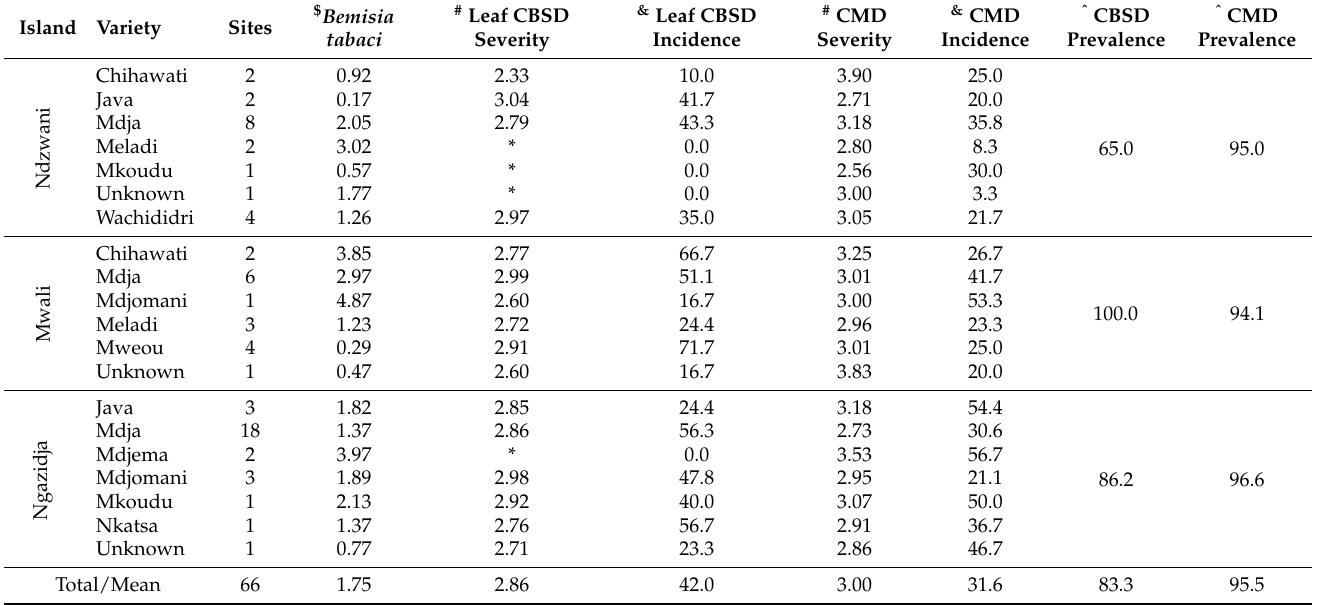
Table 1. Incidence, prevalence, and severity of cassava virus diseases and abundance of the whitefly Bemisia tabaci for cultivars surveyed in islands of Comoros, July